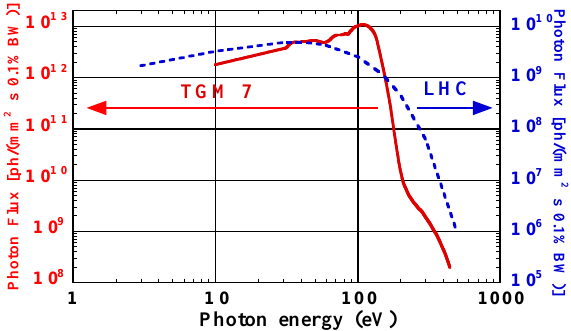
FIG. 2. (Color) A comparison between the LHC bending magnet photon flux with that obtained with the WL spectrum of the TGM7 beam line in BESSY. The integrated photon flux is 5.2 3 10 11 and 8.9 3 10 14 photons (cid:1)(cid:2) s mm 2 (cid:3) , respectively.